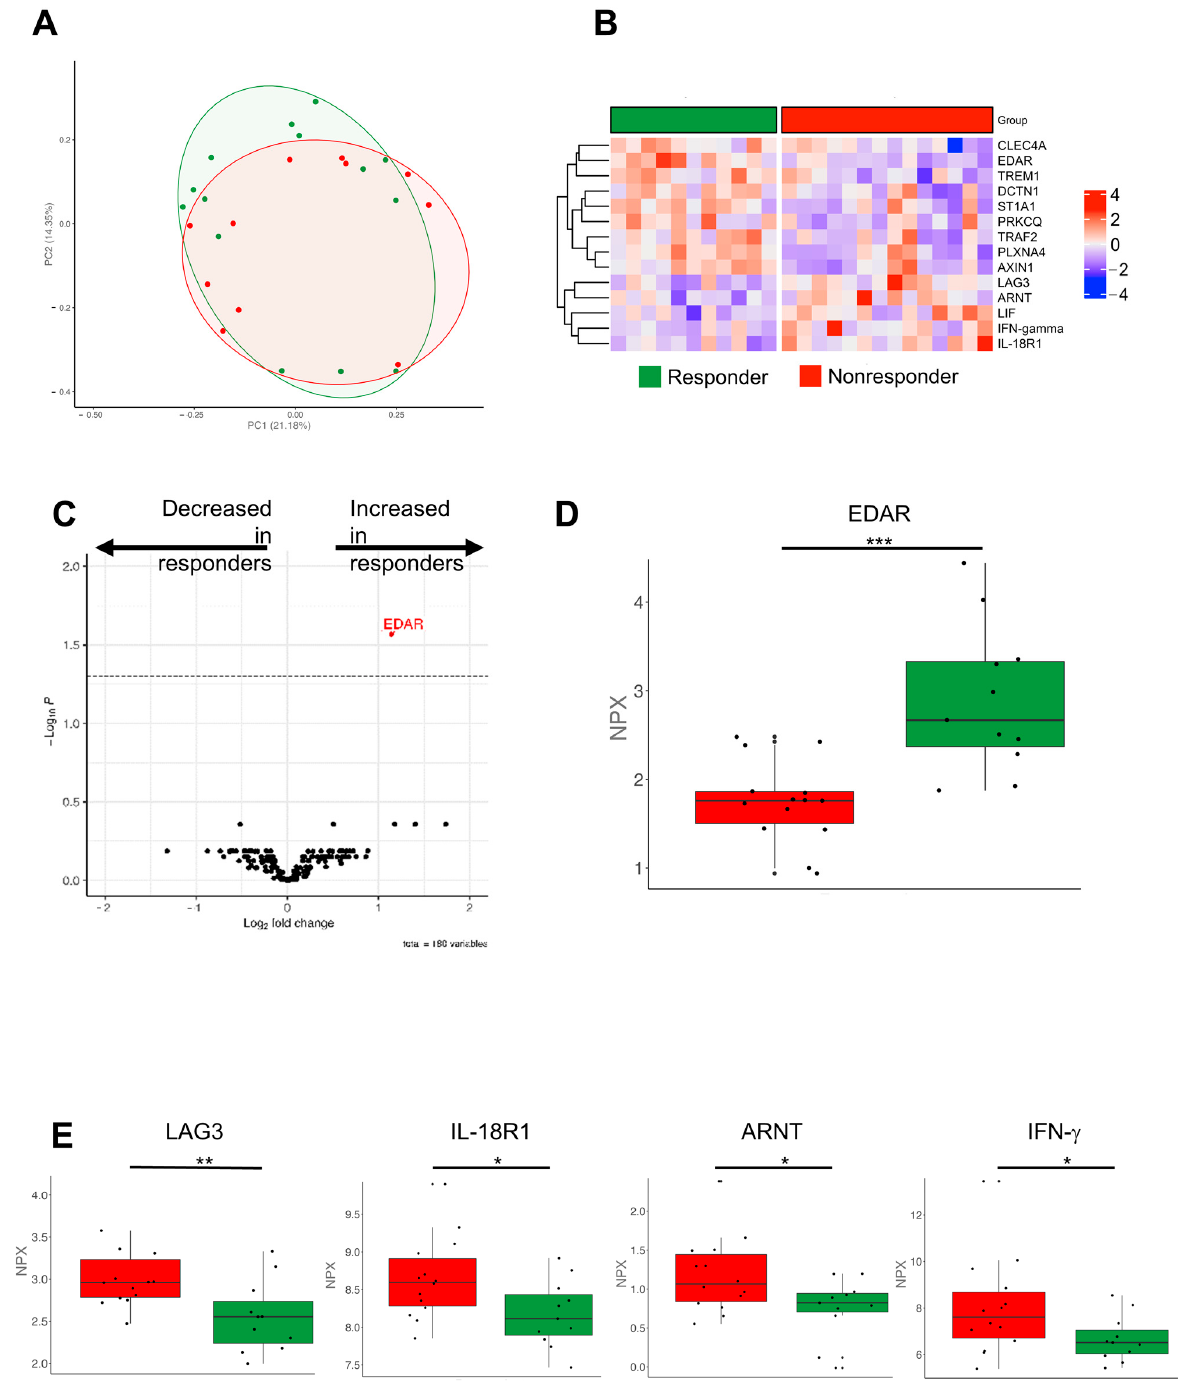
Figure 6. Olink protein analyses comparing responder and non-responder VLD patients. ( A ) Principal component analysis showing an overlap of responder (green) and non-responder (red). ( B ) Heatmap of the significant different proteins compared by applying t -test. Z-score scaling across the rows are depicted. ( C ) Heatmap showing the log2 fold changes and p -values comparing responders and non-responders. ( D ) Boxplot showing the normalized protein expression of EDAR as one of the upregulated proteins in responders with the highest p -value (***, p < 0.001). ( E ) LAG3, IL-18R1, ARNT, IFN- γ showed significant increase in the non-responder group applying t -test (**, p < 0.01; *, p < 0.05). ARNT: Aryl Hydrocarbon Receptor Nuclear Translocator, EDAR: Ectodysplasin A Receptor, IFN- γ : Interferon